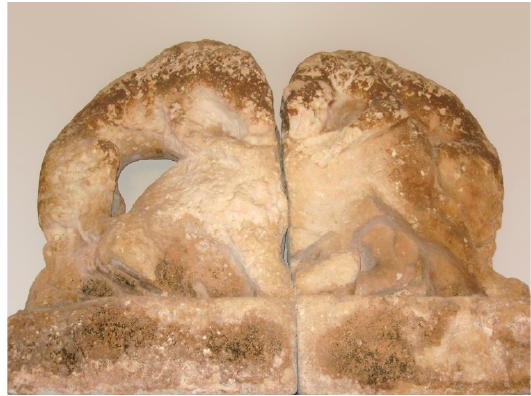
Figure 16. Rampant goats in a mosaic panel; drawing of a scene from the House of the Mosaics; ca. 6th–5th century BCE .